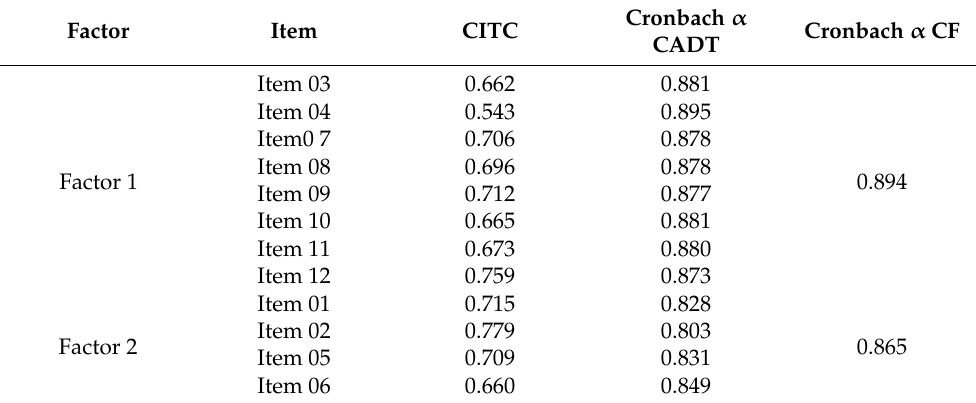
Table A3. Item-total Correlations and Reliability Measures of Factor Structure of